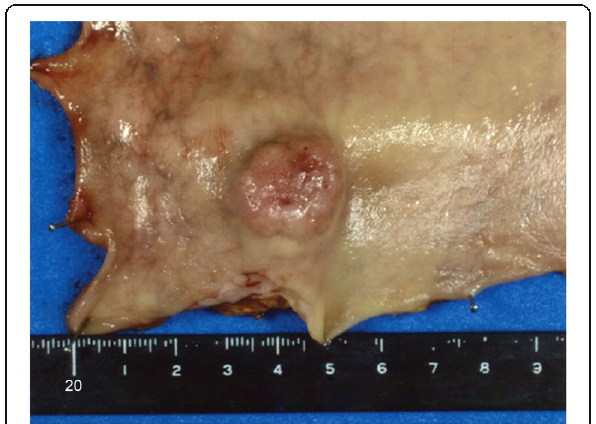
Fig. 6 Histological examination of resected specimens from the rectum (HE staining; magnification × 40). The tumor-involved region of the mucosal layer showed a normal grand ductal structure resembling a floating island, which was indicative of mucosal colonization (*). HE, hematoxylin and